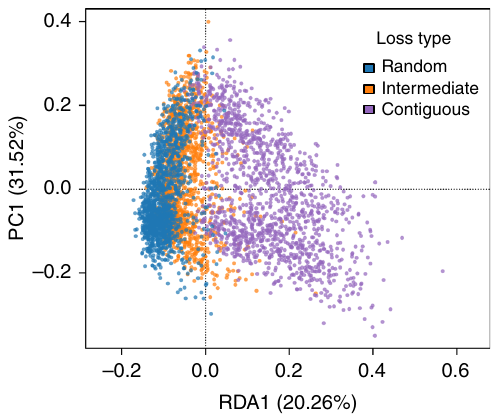
Fig. 2 Community responses to habitat loss are determined by the type of loss. Redundancy analysis of community responses to HL constrained by HL type shows a clear separation of community responses to HL according to the type of loss experienced: random, intermediate or contiguous. The constrained (RDA1) and unconstrained (PCA1) axes (RDA1) explain a 20.26% and 31.52%, respectively, of the variability observed in the